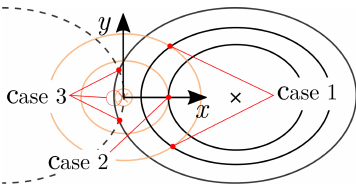
Figure 6. Sketch of three example cases for intersecting ellipses.